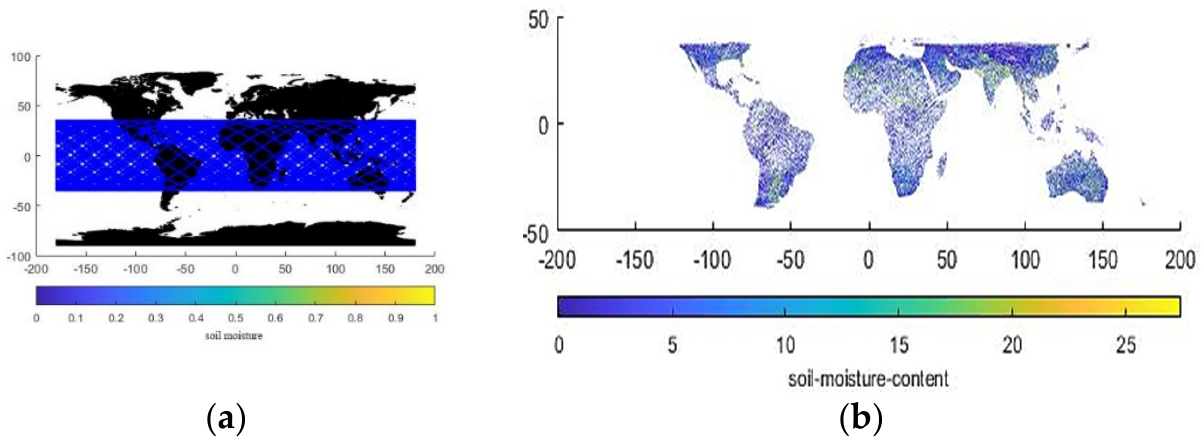
Figure 2. ( a ) CYGNSS L1 global data availability and ( b ) DDM SNR in August 2019.